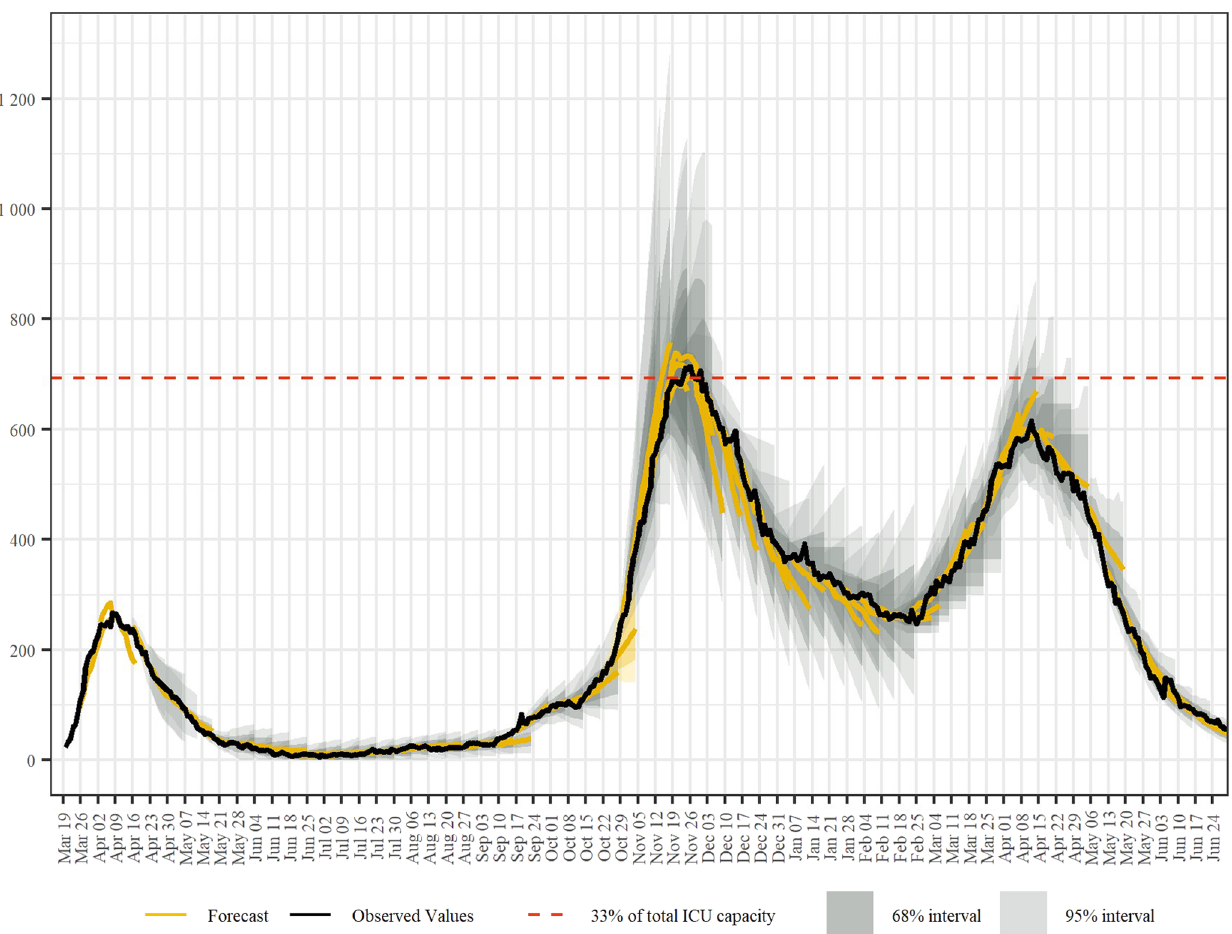
Fig. 4 Forecasting bed usage. Rolling combined and consolidated out-of-sample forecasts for the number of intensive care beds currently in use for COVID-19 patients including corresponding CI, the actual numbers of beds occupied, and 33% of total ICU capacity as a reference. The underlying data is found in Supplementary Data